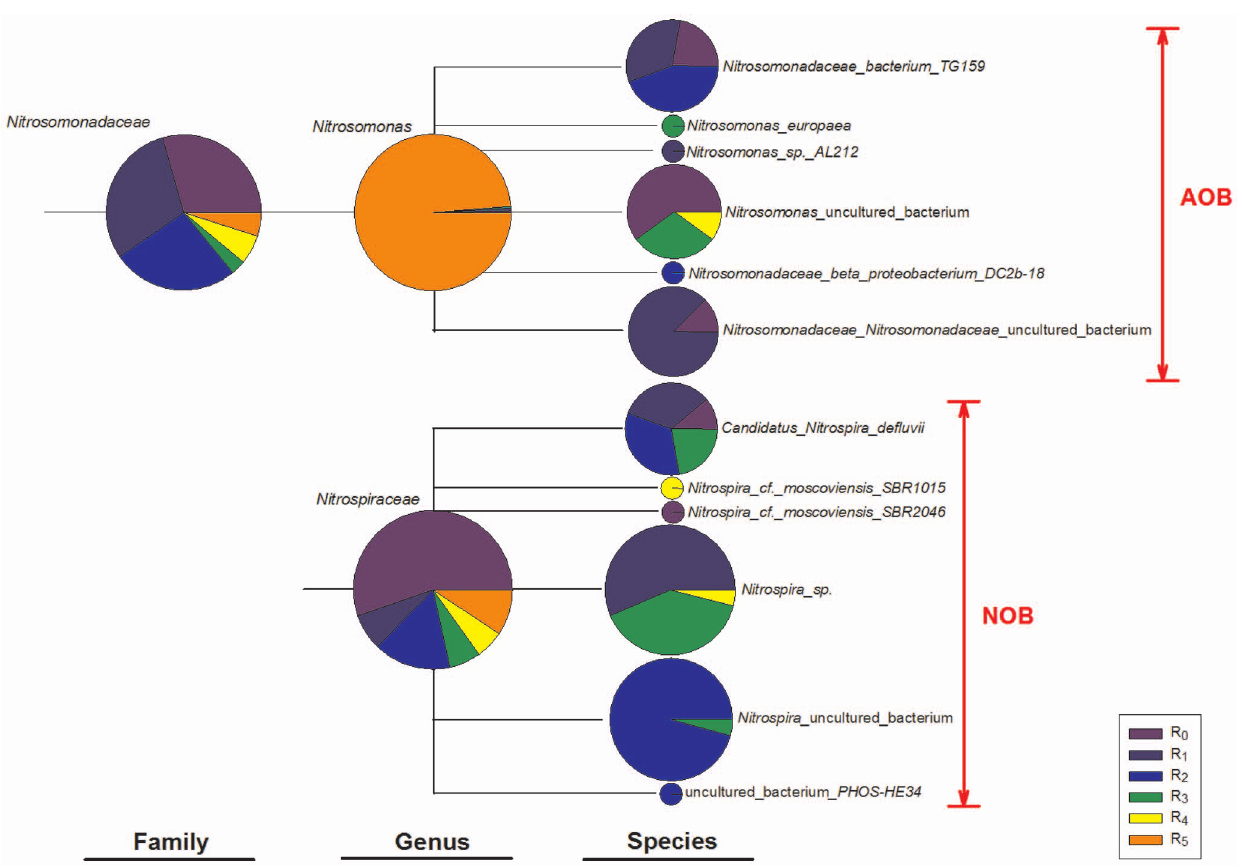
Figure 5. AOB and NOB sequences from R 0 –R 5 assigned to NCBI taxonomies using BLAST and MEGAN.